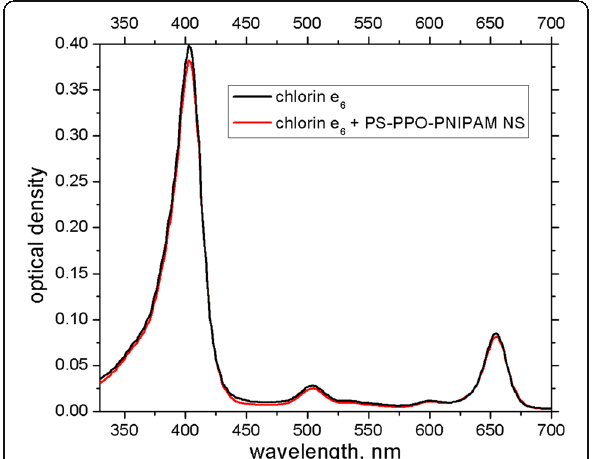
Fig. 4 Absorption spectra of chlorin e 6 (2 μ M) free (black line) and in the presence of PS-PPO-PNIPAM hybrid nanosystems (red line) in 50 mM Tris-HCl buffer, pH 7.2